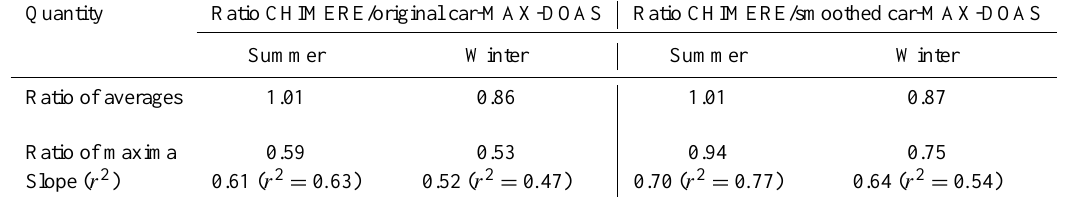
Table 2. Ratios of daily average and maximum values (CHIMERE/car-MAX-DOAS) as well as slopes and correlation coefficients of the regression analyses for measurements at large circles.